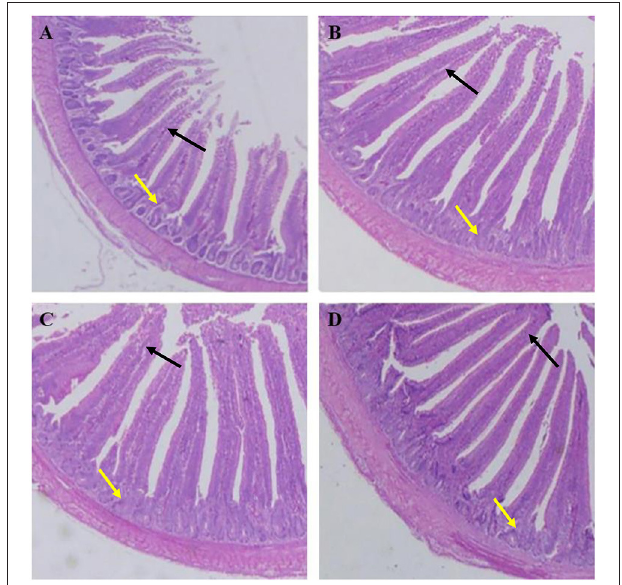
FIGURE 1 | Dietary plectasin increased the ileum villus length while decreased crype depth of 21-day-old yellow-feathered chickens. (A) The ileum of basal